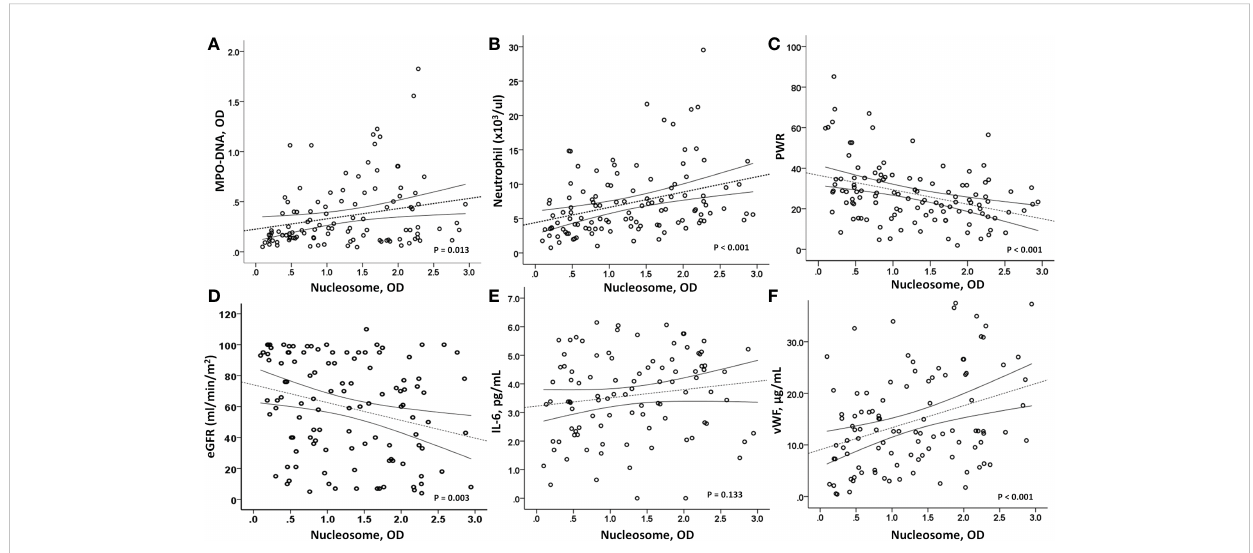
FIGURE 2 Correlation analysis. (A) As a marker of NETosis, circulating nucleosome levels were closely associated with MPO-DNA levels (p=0.013). (B, C) In addition, a strong correlation between circulating nucleosome levels and peripheral neutrophils (p<0.001) and platelet/WBC ratio (p<0.001) was observed. (D) And the nucleosome levels were inversely associated with renal function, eGFR (p=0.003). Interestingly, (E) nucleosome levels did not correlate with IL-6 (p=0.133), but (F) a strong positive association was observed with vWF levels (p<0.001), suggesting a close relationship between high nucleosome levels and endothelial dysfunction. MPO-DNA, myeloperoxidase-DNA; PWR, platelet/WBC ratio; eGFR, estimated glomerular fi ltration rate; IL-6, interleukin-6; vWF, von-Willebrand factor.